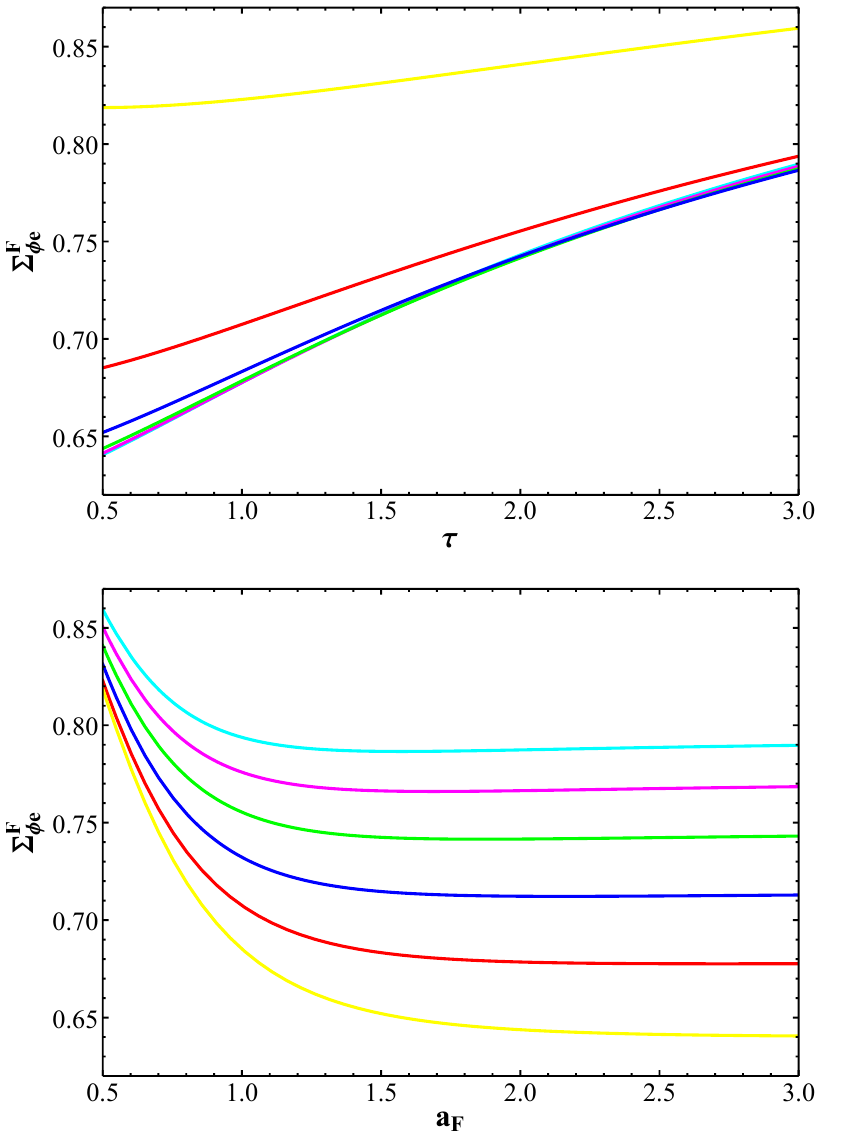
Figure 9 . (Top) The sum Σ F defined in eq. (3.12), which encapsulates the dependence of the DM- φe electron scattering cross section on parameters of the model of the extra dimension, as a function of τ for a F = 3 (cyan), 5/2 (magenta), 2 (green), 3/2 (blue), 1 (red), and 1/2 (yellow), respectively. (Bottom) As in the previous panel, but now as a function of a F assuming τ = 3 (cyan), 5/2 (magenta), 2 (green), 3/2 (blue), 1 (red), and 1/2 (yellow),